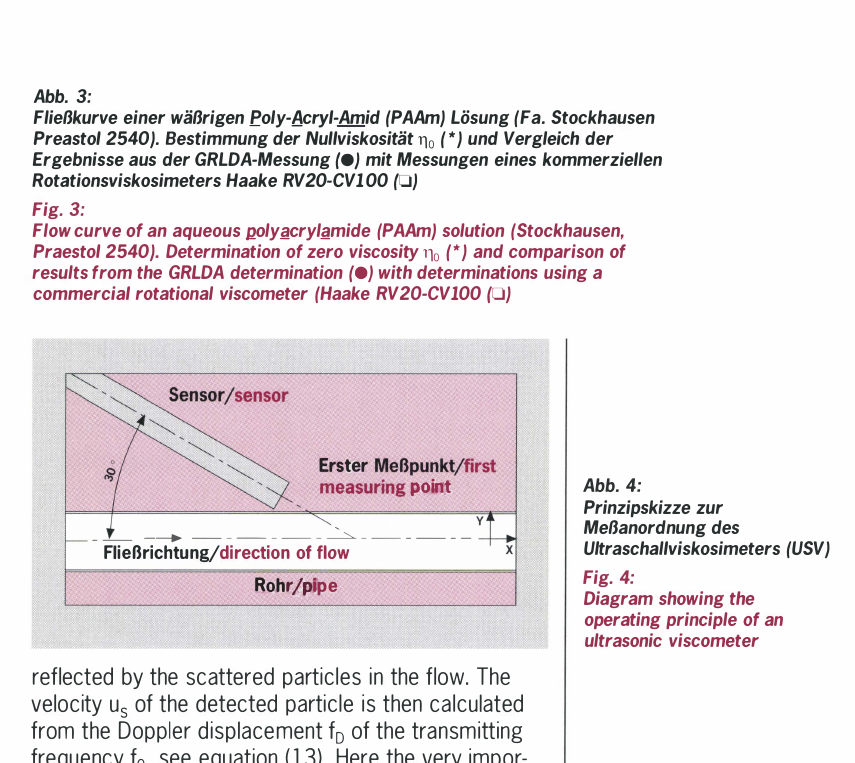
Fig. 4: Diagram showing the operating principle of an ultrasonic